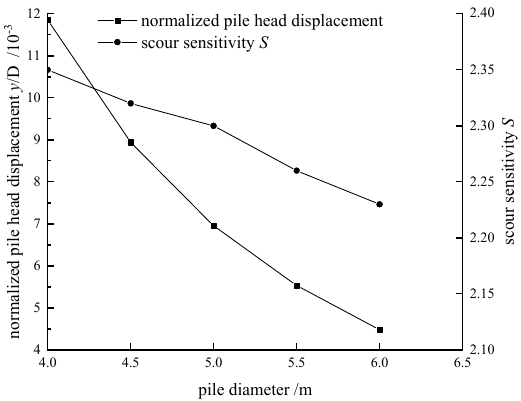
Figure 16. Pile displacement and scour sensitivity variation with pile diameter.